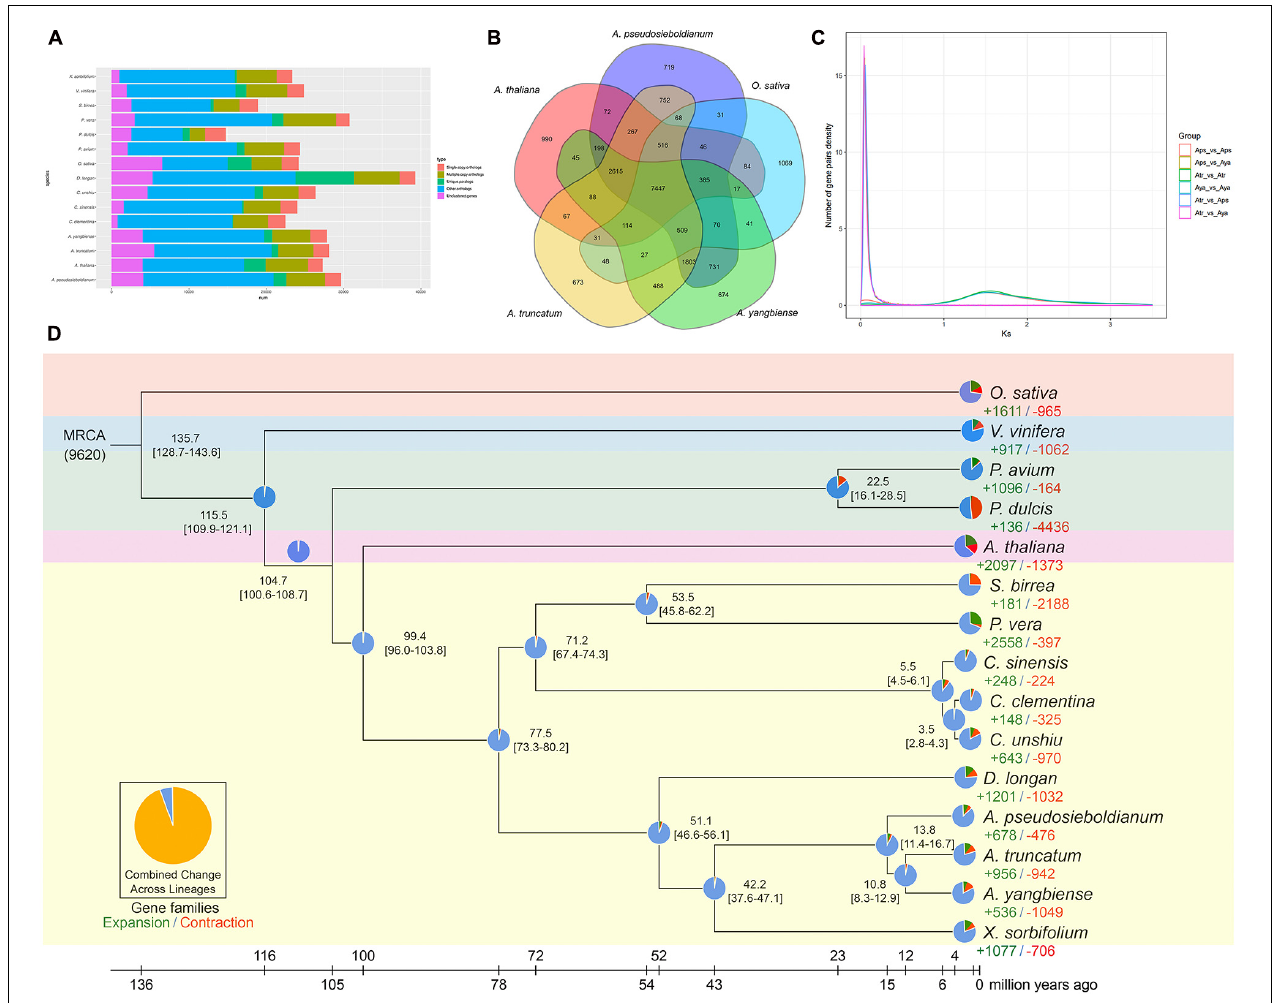
FIGURE 3 | Gene family, phylogenetic analysis, and 4dTV and K s distribution of A. pseudosieboldianum and Acer species. (A) Number of genes in various plant species, showing a high gene number for A. pseudosieboldianum compared with other species. (B) Venn diagram of the gene family between A. pseudosieboldianum , A. yangbiense , A. truncatum , A. thaliana , Populus trichocarpa, and O. sativa . (C) Distribution of K s . (D) Species tree on the basis of 347 single-copy orthologs from 16 plant